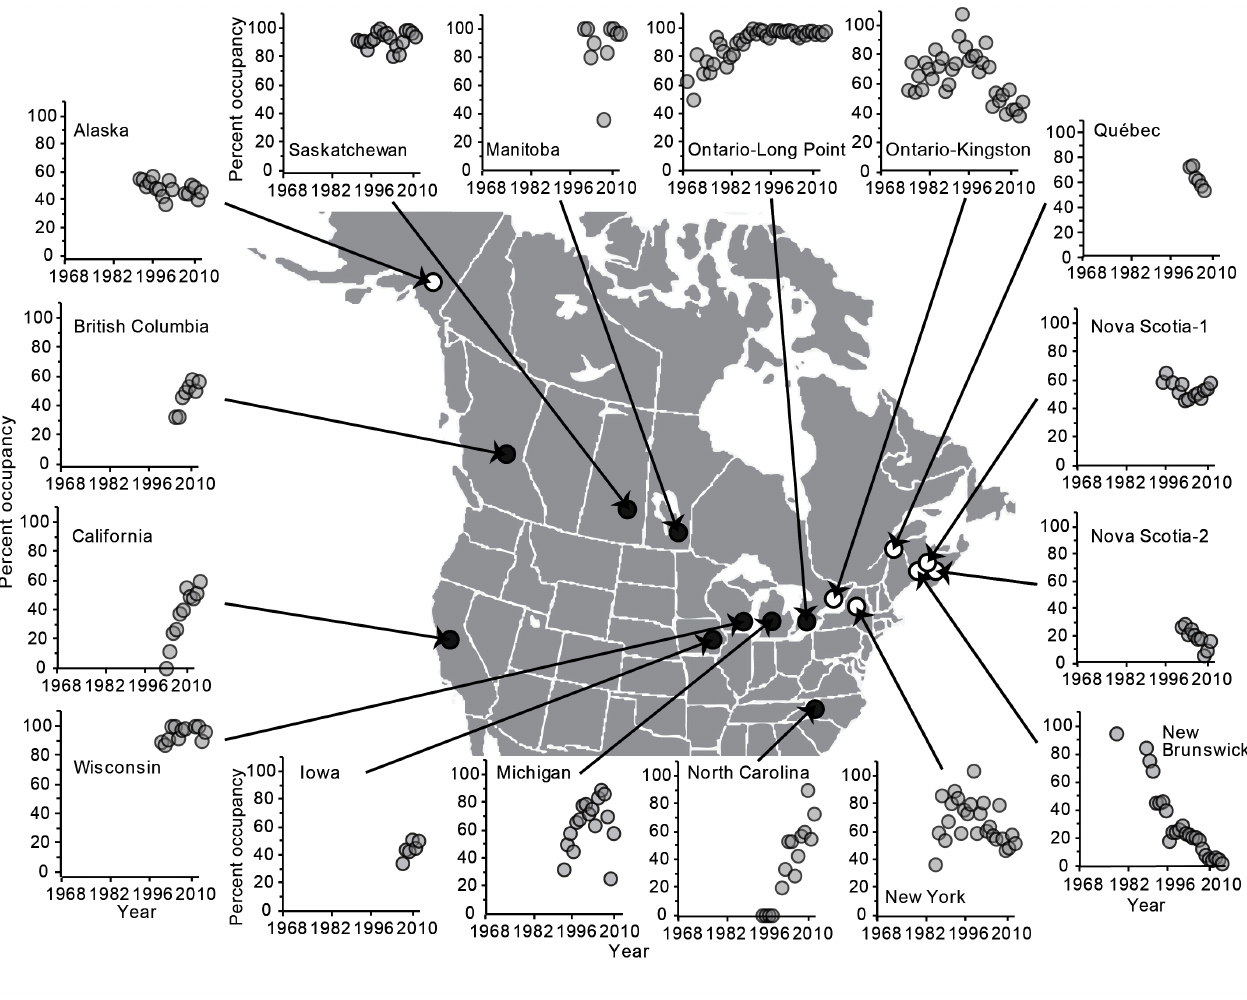
Fig. 1 . Location and occupancy rates over time of Tree Swallow sites. Scatterplots associated with open circles over sites have negative trends (Table 1); closed circles indicate increasing